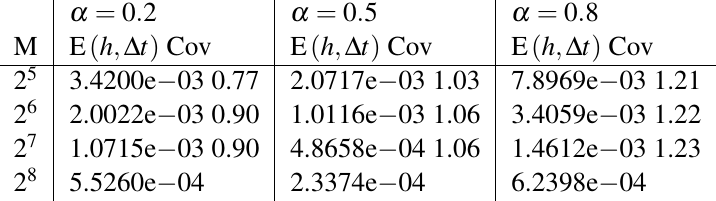
Table 2 L 2 error and corresponding time convergence order of finite difference decomposition at h = 2 − 12 α = 0 . 2 α = 0 . 5 α = 0 . 8